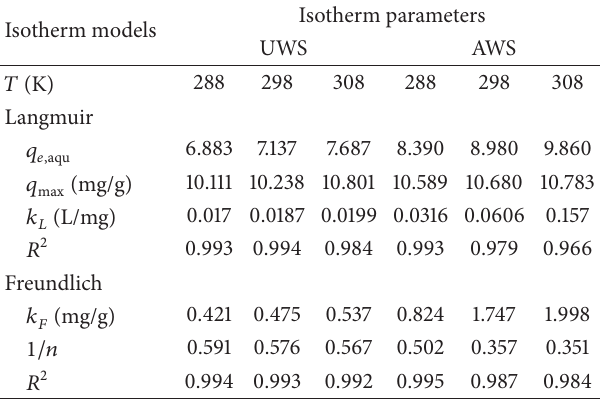
Table 1: Isotherm parameters obtained for the adsorption of Cu(II) onto wheat straw at different initial concentrations and